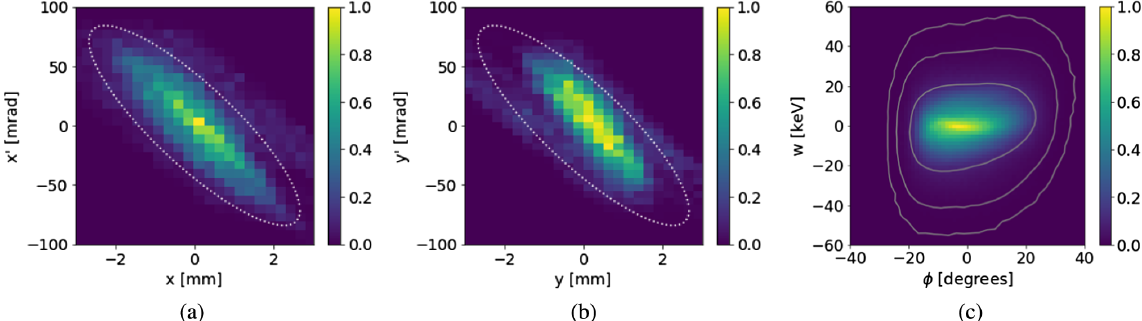
FIG. 2. Fully projected phase space plots for initial (2(a), 2(b)) and output (2(c)) distributions from PARMTEQ simulation. Density is plotted in linear scale. Dotted lines in (2(a), 2(b)) show the RFQ acceptance ellipse α ¼ 1 . 6 , β ¼ 0 . 06 at ϵ ¼ 1 . 4 mm mrad [norm.]. The contours on (2(c)) show the 10%, 1%, and 0.1% threshold